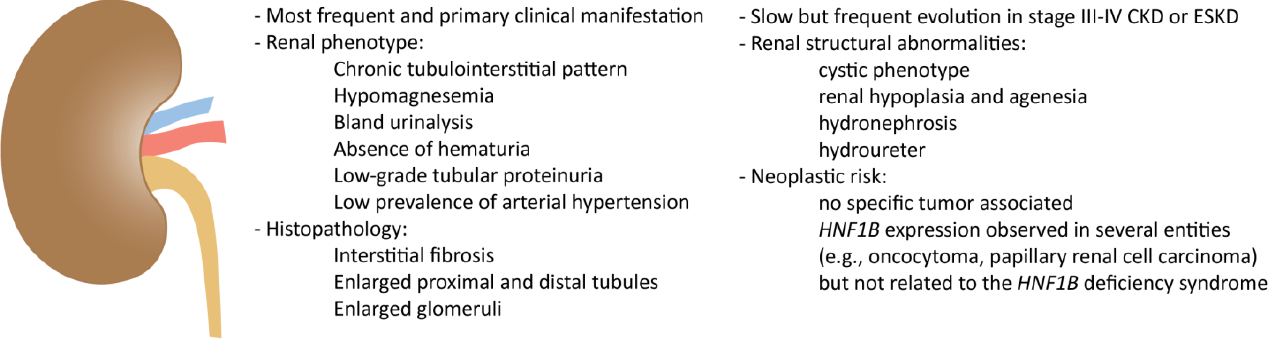
Figure 1. The HNF1B deficiency and the